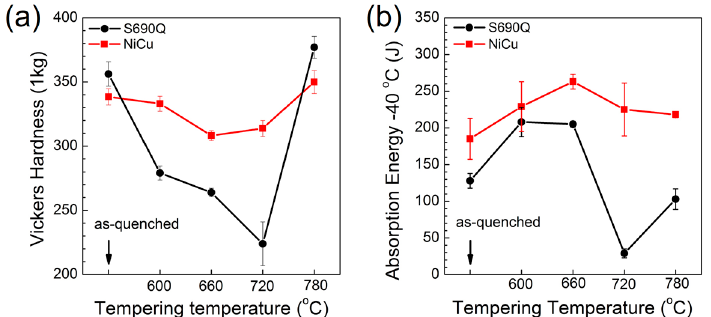
Figure 4. ( a ) Vickers hardness and ( b ) impact toughness ( − 40 °C) of two steels after quenching and tempering.